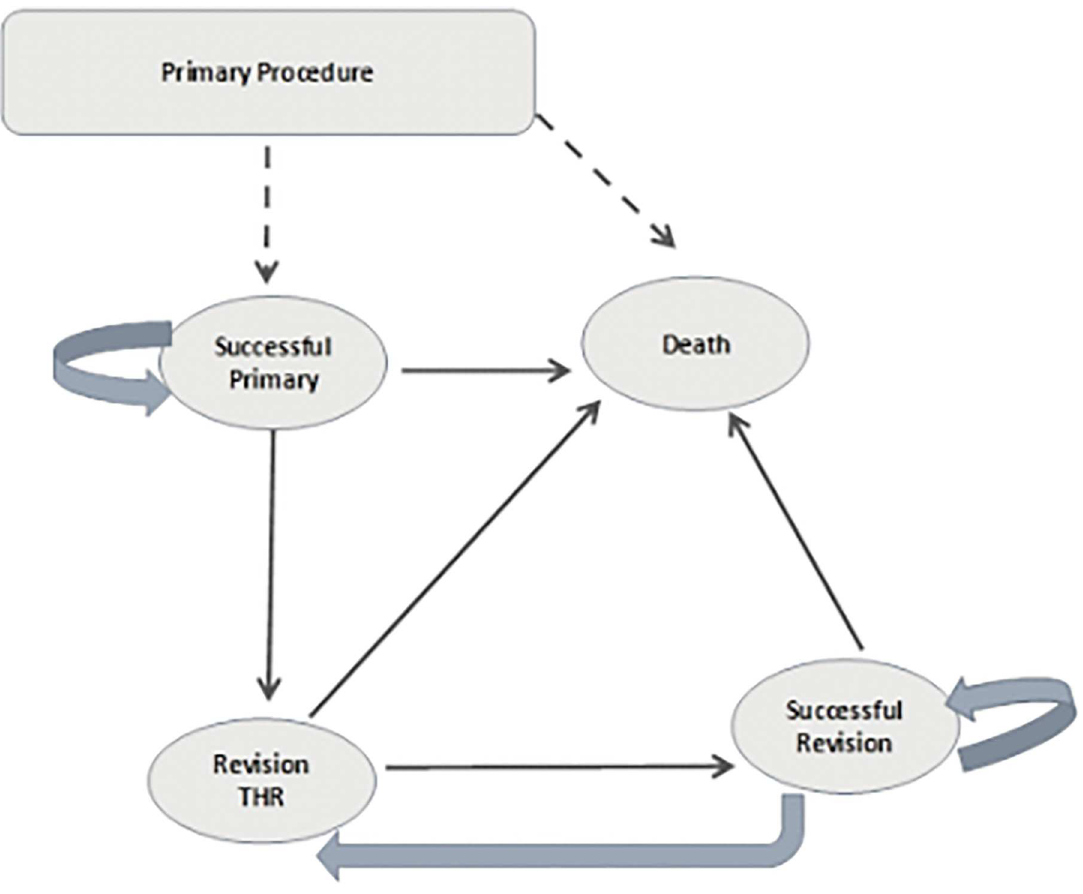
Fig 1. Semi-Markov model